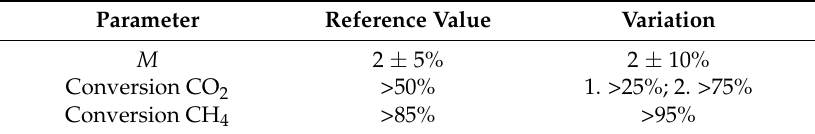
Table 9. Variations in requirements on reaction.